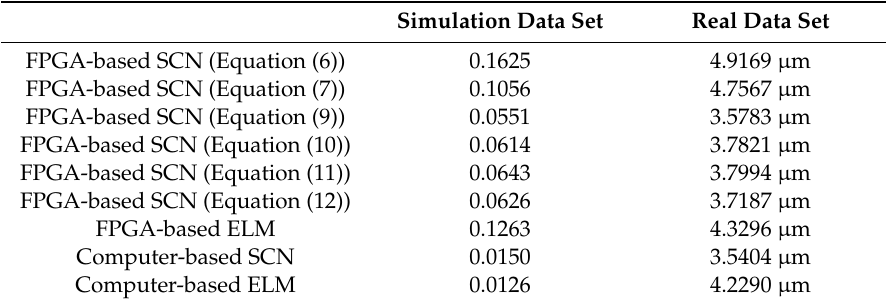
Figure 5. Comparison of SCN (Formulas (6), (7), (9)) and ELM implementation on the real data set. Table 4. Average root-mean-square error (RMSE) of the prediction results.